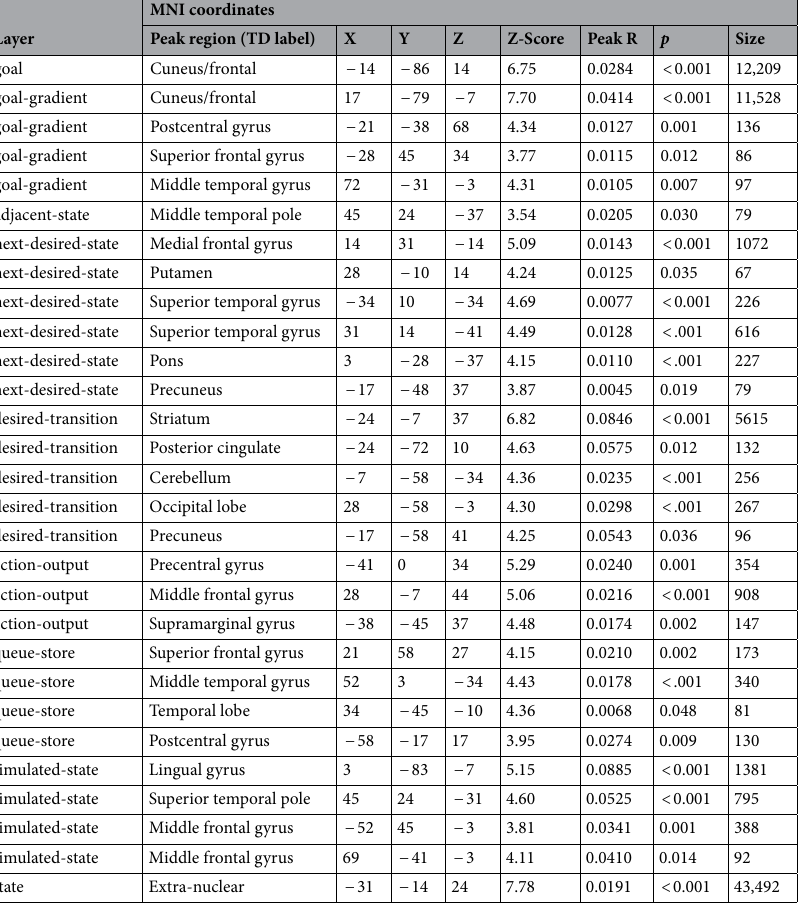
Table 1. Significant similarity clusters for RSA analysis. The p and Size columns refer to cluster-corrected values. Anatomical labels are derived from the Automated Anatomical Labeling Atlas in SPM5 46